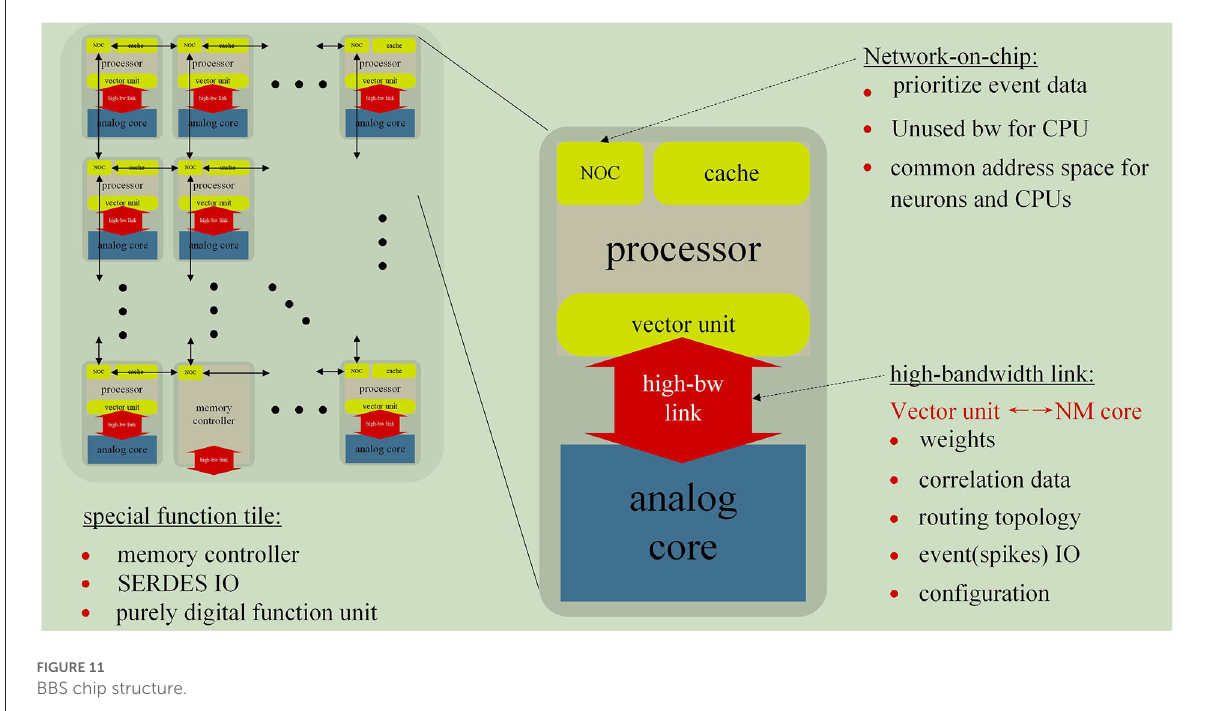
FIGURE11 BBS chip